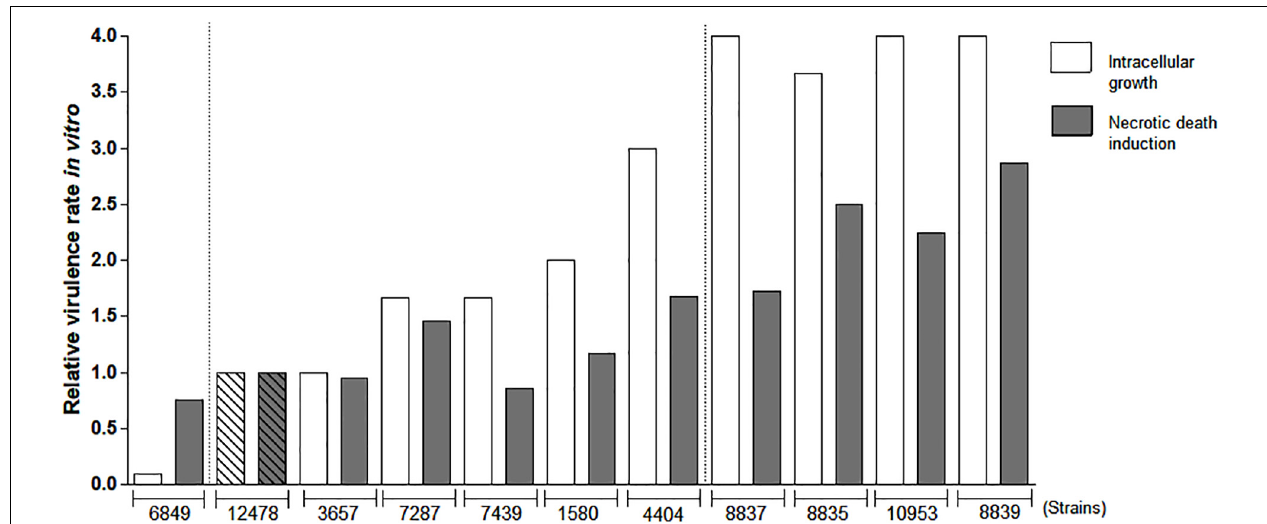
FIGURE 2 | Evaluation of relative virulence of Mycobacterium kansasii strains as measured by in vitro macrophage infection. Mycobacterial ability to intracellular growth in macrophages and induction of macrophage death was evaluated to calculate relative virulence of each M. kansasii isolate compared with that of the reference virulent M. kansasii strain 12478. RAW264.7 macrophage-like cells were infected with the studied strains at a multiplicity of infection (MOI) of 1:1 and cultured for 4 days. Intracellular bacterial growth was evaluated by CFU test. The mean growth value of reference strain 12478 was established as 1.0 and relative growth rate of each clinical isolate was calculated proportionally. To evaluate macrophage death, the cells were infected at a MOI of 10:1, cultured for 3 days, and necrotic cell death was evaluated by quantification of lactate dehydrogenase (LDH) release (LDH test). Relative cytotoxicity of each isolate in relation to the cytotoxicity of reference strain 12478 (established as 1.0) was calculated